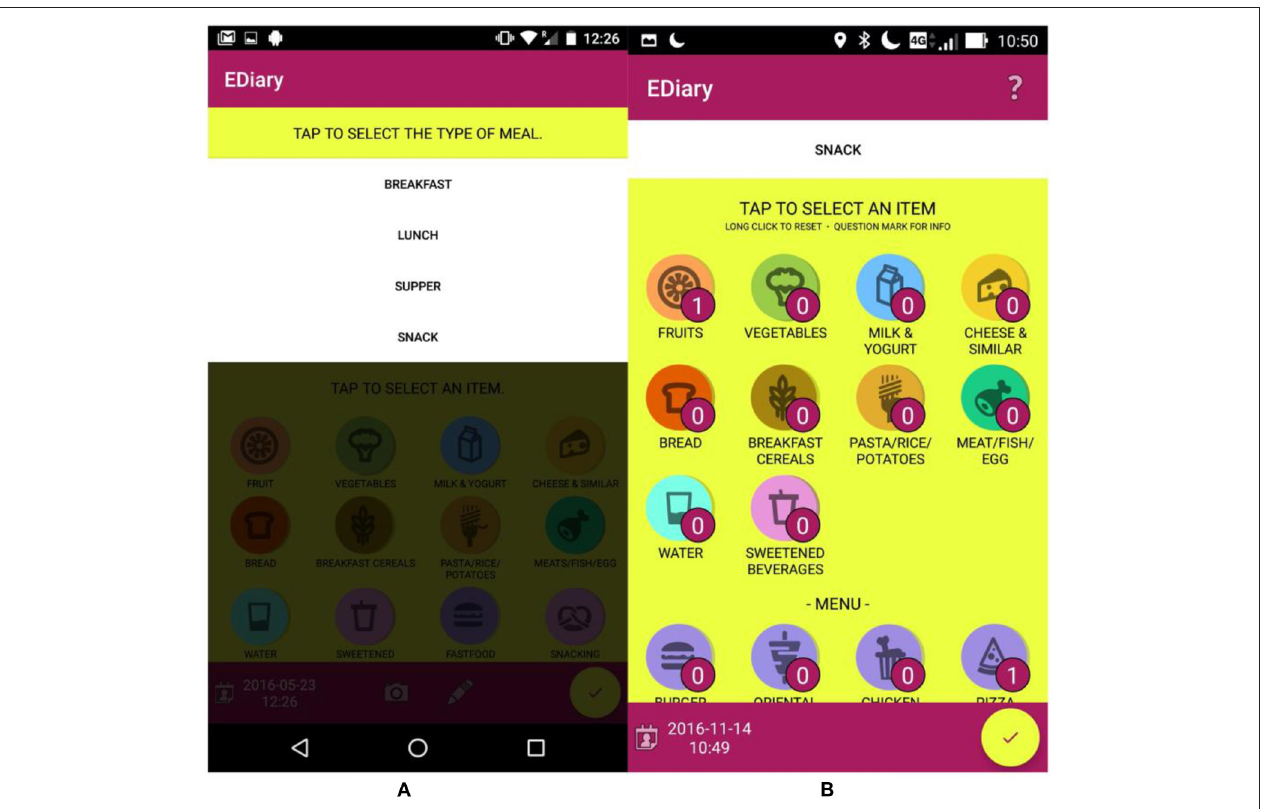
FIGURE 3 | e-Diary app interface: (A) shows the selection of type of meal; (B) shows the interface for the selection of the foods eaten during the meal.